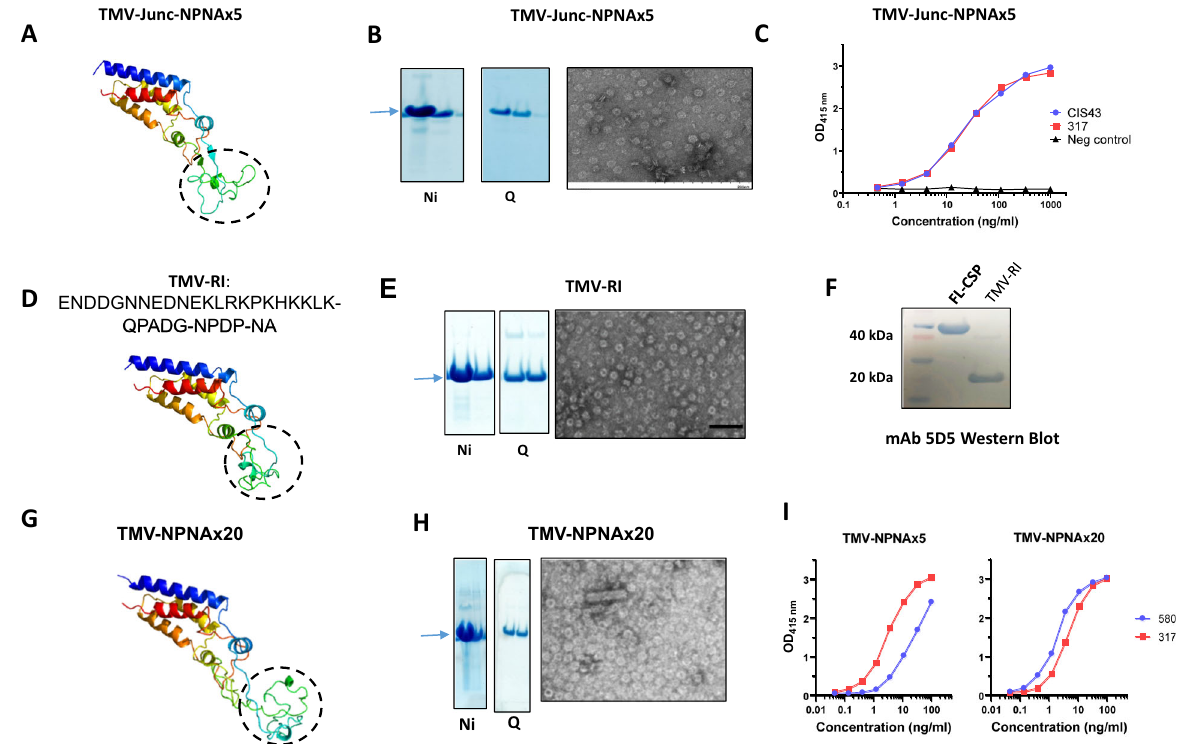
Fig. 5 Characterization of antigens used in Study 2. TMV-Junc-NPNAx5, TMV-RI, and TMV-NPNAx20. A , D , G Rosetta predicted monomer structures of TMV-Junc-NPNAx5, TMV-RI, and TMV-NPNAx20. Images were generated using PyMOL. B , E , H Left panels show coomassie blue- stained SDS-PAGE gel bands (arrows) of Nickel and Q-Sepharose puri fi ed proteins; right panels show electron micrographs for each antigen. C ELISA reactivity curves of TMV-Junc-NPNAx5 binding to mAb CIS43, mAb 317, or PBS control. F Western blot using Region I speci fi c mAb 5D5 against TMV-RI and FL-CSP antigen. I Representative ELISA curves of TMV-NPNAx20 and TMV-NPNAx5 reactivity to mAb 580 and mAb